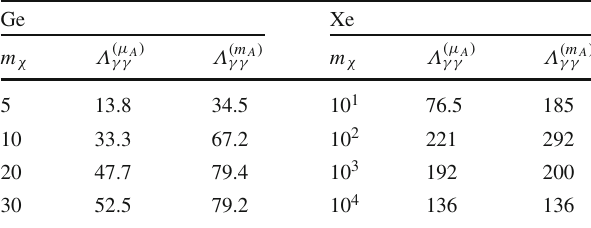
Table 2 Comparison of Λ γγ constraint by using μ A or m A . μ A should be used for the low DM mass range that is favored by Z pole